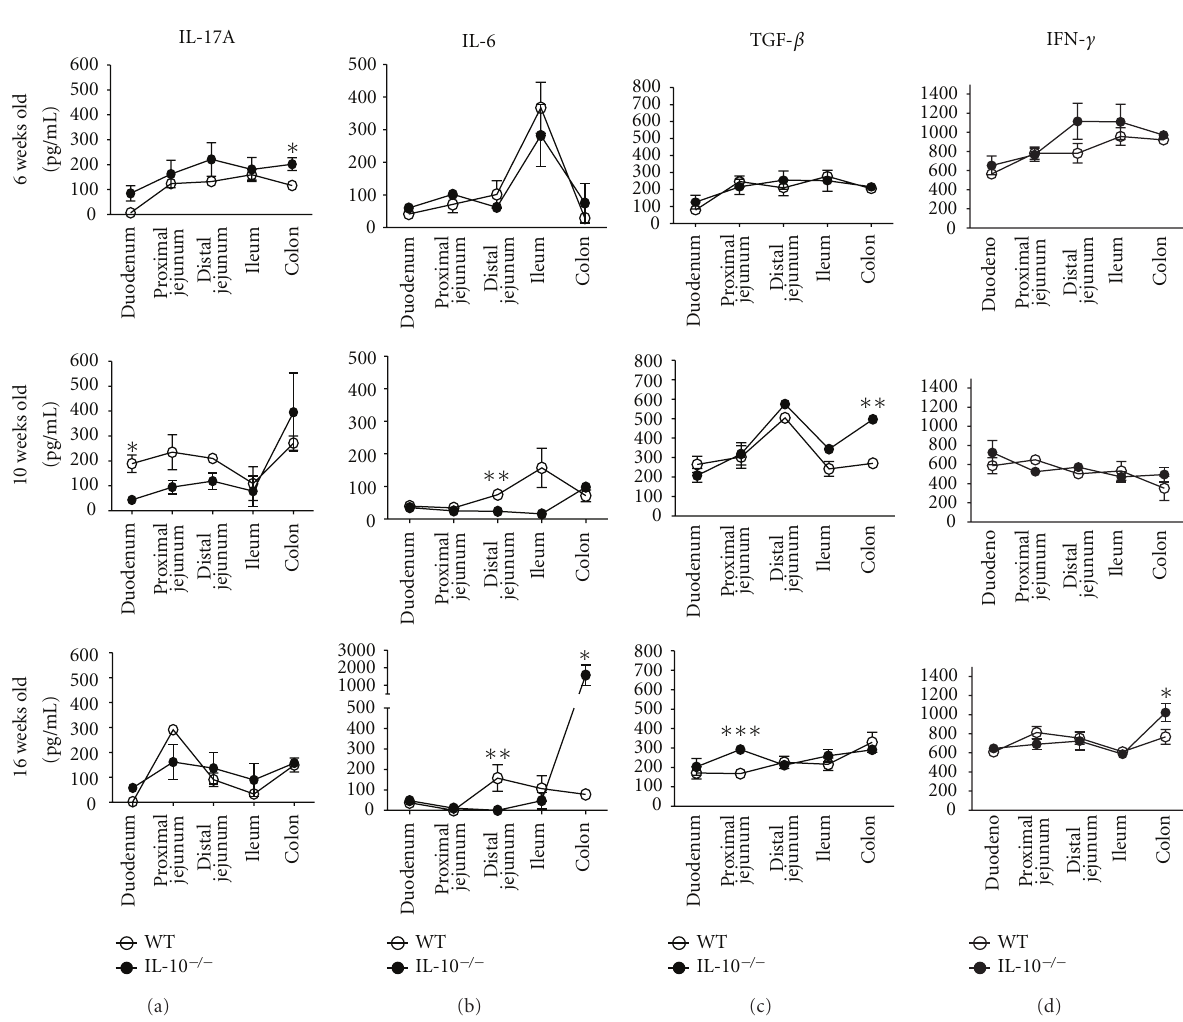
On the other hand, in IL-10-deficient mice,